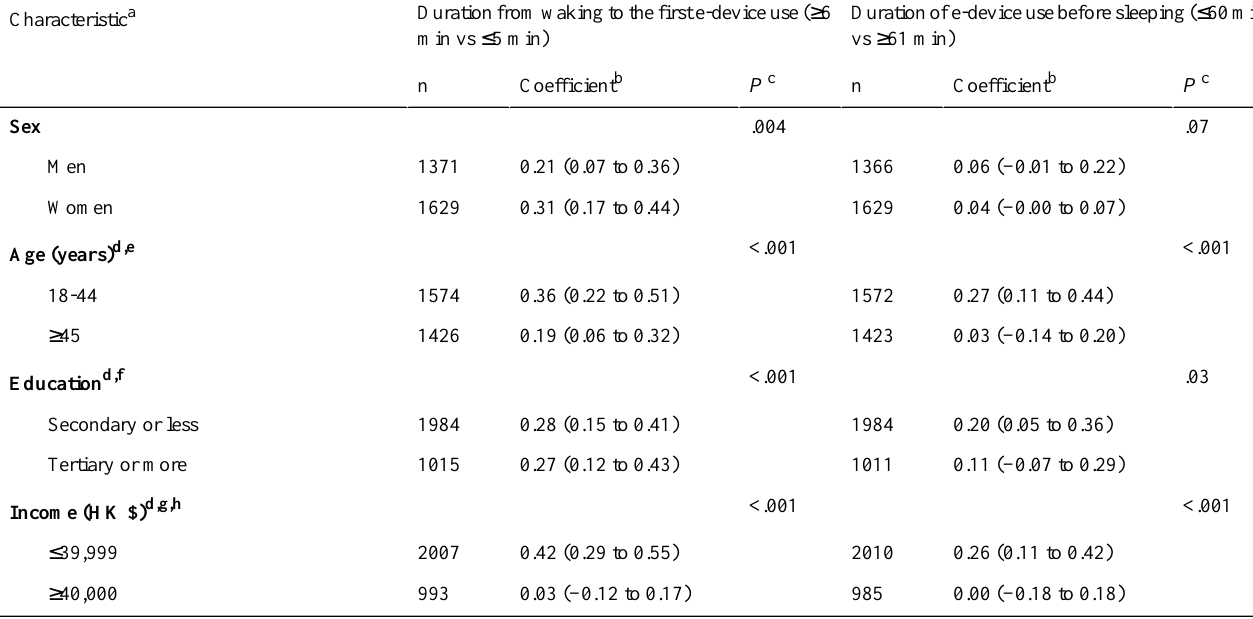
Table 7. Interaction effect between Hong Kong adults’demographics and e-device use for depressive symptoms.